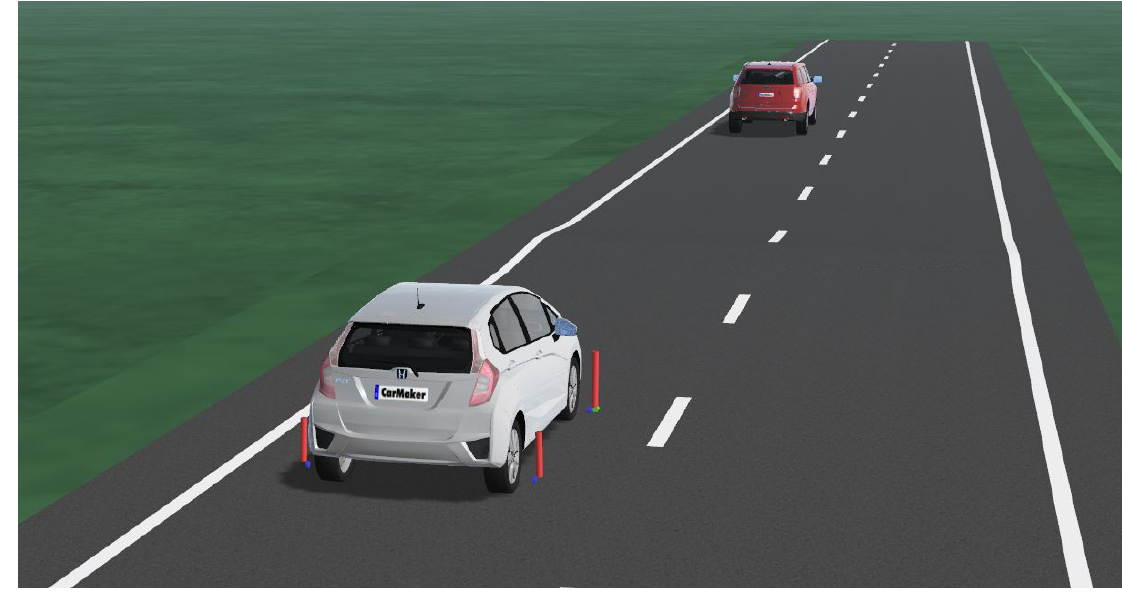
Figure 6. Performance evaluation scenario including ego, target vehicle and a road bump